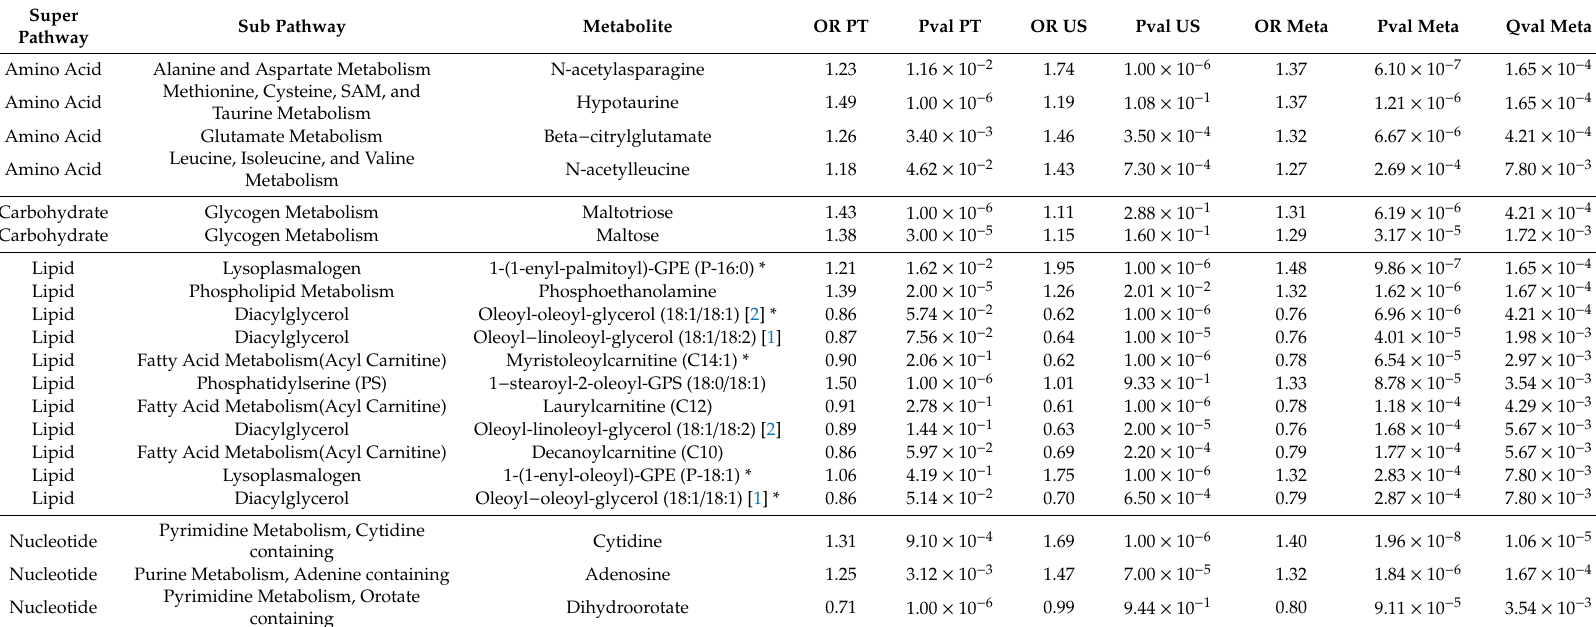
Table 3. Top 20 significant metabolites identified on the meta-analysis of the two cohorts for the comparison across all study